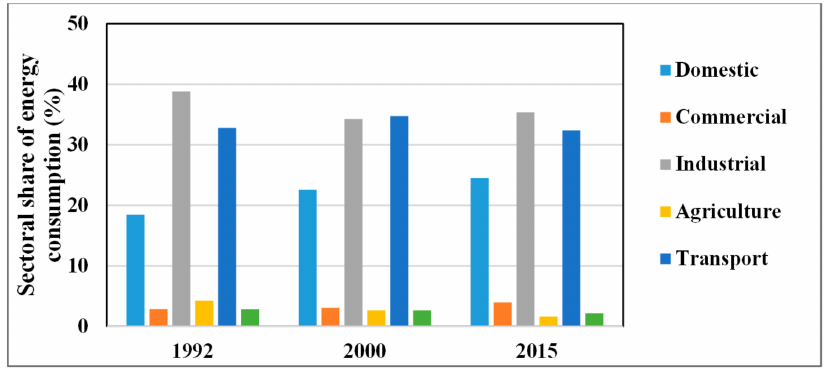
Figure 2. Historical sector-wise energy consumption [69–73].